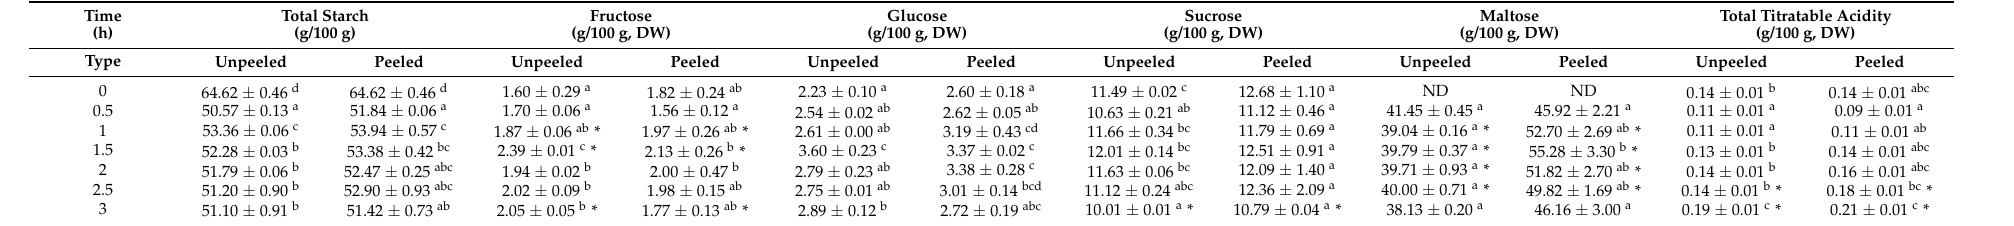
Table 2. Analysis of sugar composition and total titratable acidity of sweet potatoes by different roasting